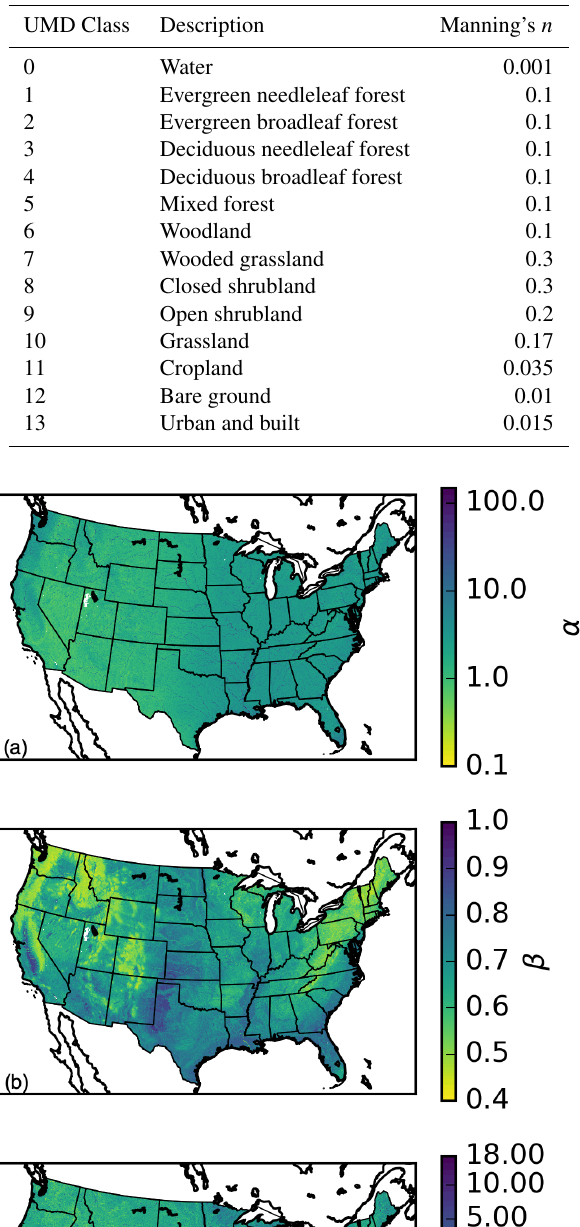
Table 5. Description of overland flow parameterizations.